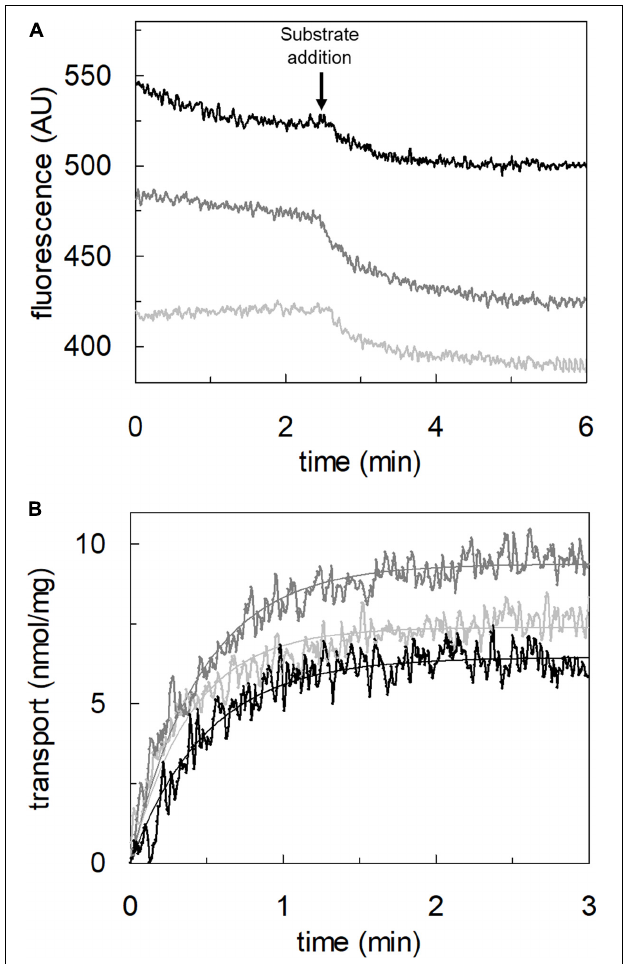
FIGURE 9 | Effect of pH on proton transport by hASCT2 reconstituted in proteoliposomes. Purified hASCT2 was reconstituted in proteoliposomes buffered at pH 7.0, containing 10 mM glutamine and 0.1 mM pyranine, as described in materials and methods. In (A) , the fluorescence measurement was started by adding 150 µ L proteoliposomes to the transport buffer (up to 3 mL final volume) composed by 100 mM Na-gluconate and Hepes Tris 20 mM at pH 6.0 (light gray) or pH 6.5 (gray) or pH 7.0 (black). After ∼ 2 min, as indicated by the arrow, 5 mM buffered glutamate was added to the sample and fluorescence change was recorded. The fluorescence signal is indicated as arbitrary units (AU). In (B) , data from (A) were converted in nmol of transported proton measured as nmol/mg; the calculation was performed after calibrating the fluorescence signal assuming a linear relationship between fluorescence decrease and proton uptake (Gibrat and Grignon, 2003). Data were plotted according to a first-order rate equation. Results are representative of three independent experiments.